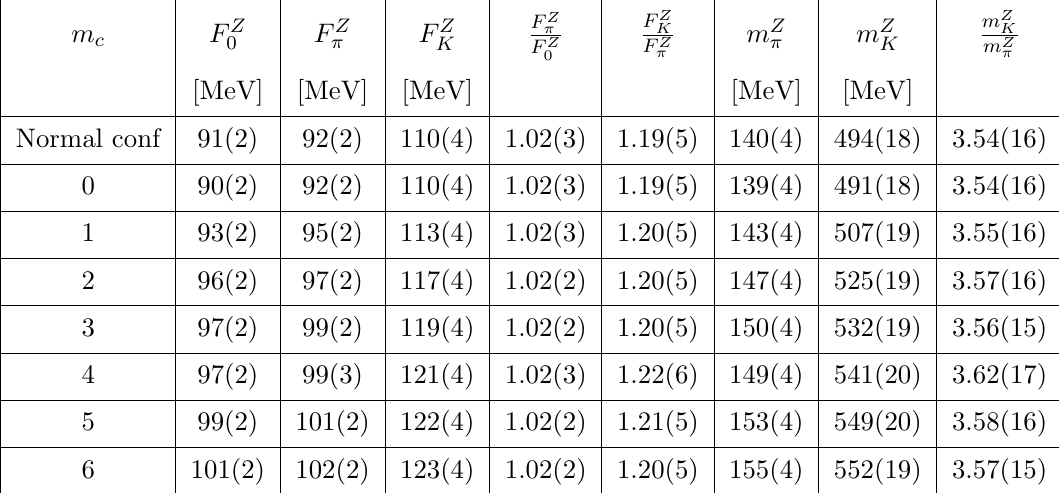
, F Z , and F Z and the ratios of these decay constants. (cid:25) 0 K Z and m Z and the mass ratio m . The decay constant in the chiral K (cid:25) K m Z (cid:25)